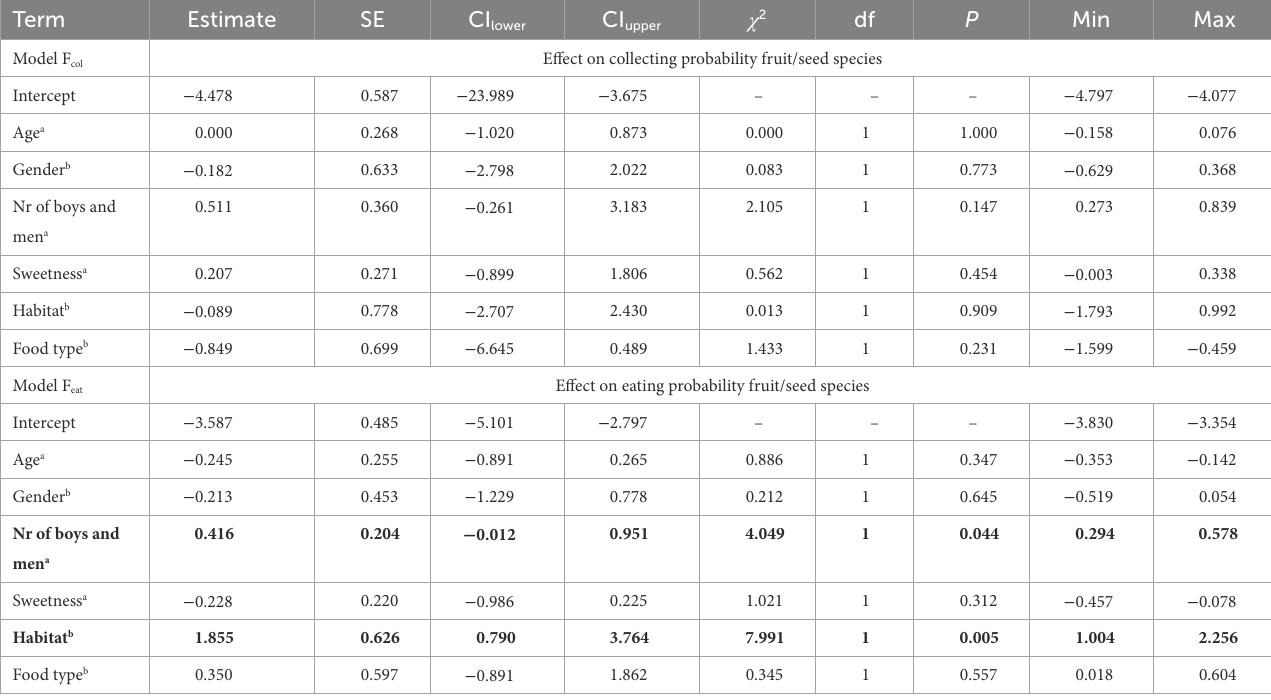
TABLE 1 Probability of collecting and eating fruit and seed species.